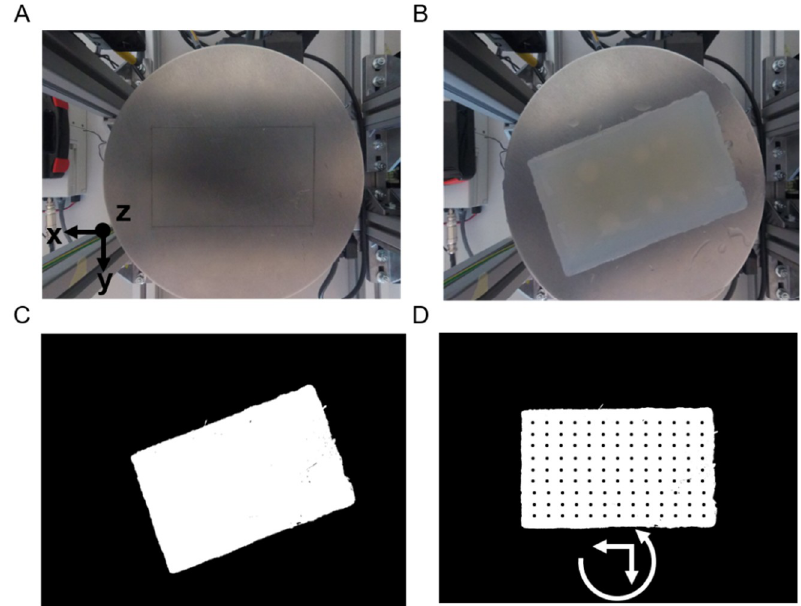
Figure 4. Visual part: Positioning of the sample, boundary detection and creation of the indentation matrix. ( A ) Background. ( B ) Sample in an arbitrary position. ( C ) Background subtraction. ( D ) Positioning by rotation of the sample and creation of the indentation matrix.